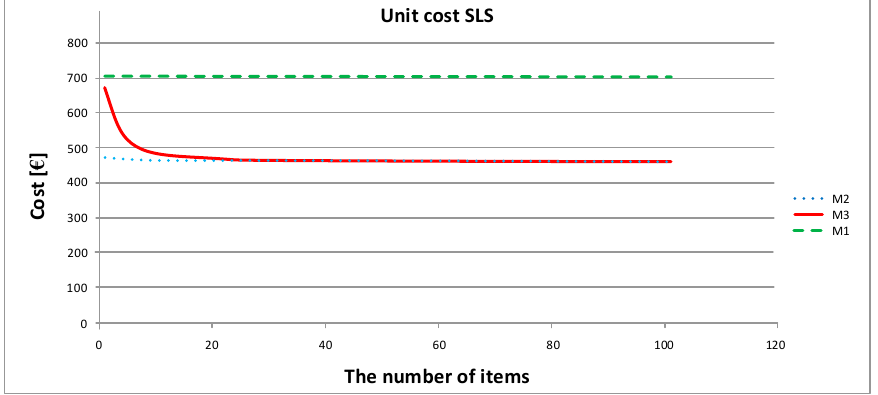
Figure 11. Dependence of the rotor production costs on the number of prototypes for SLS technology.